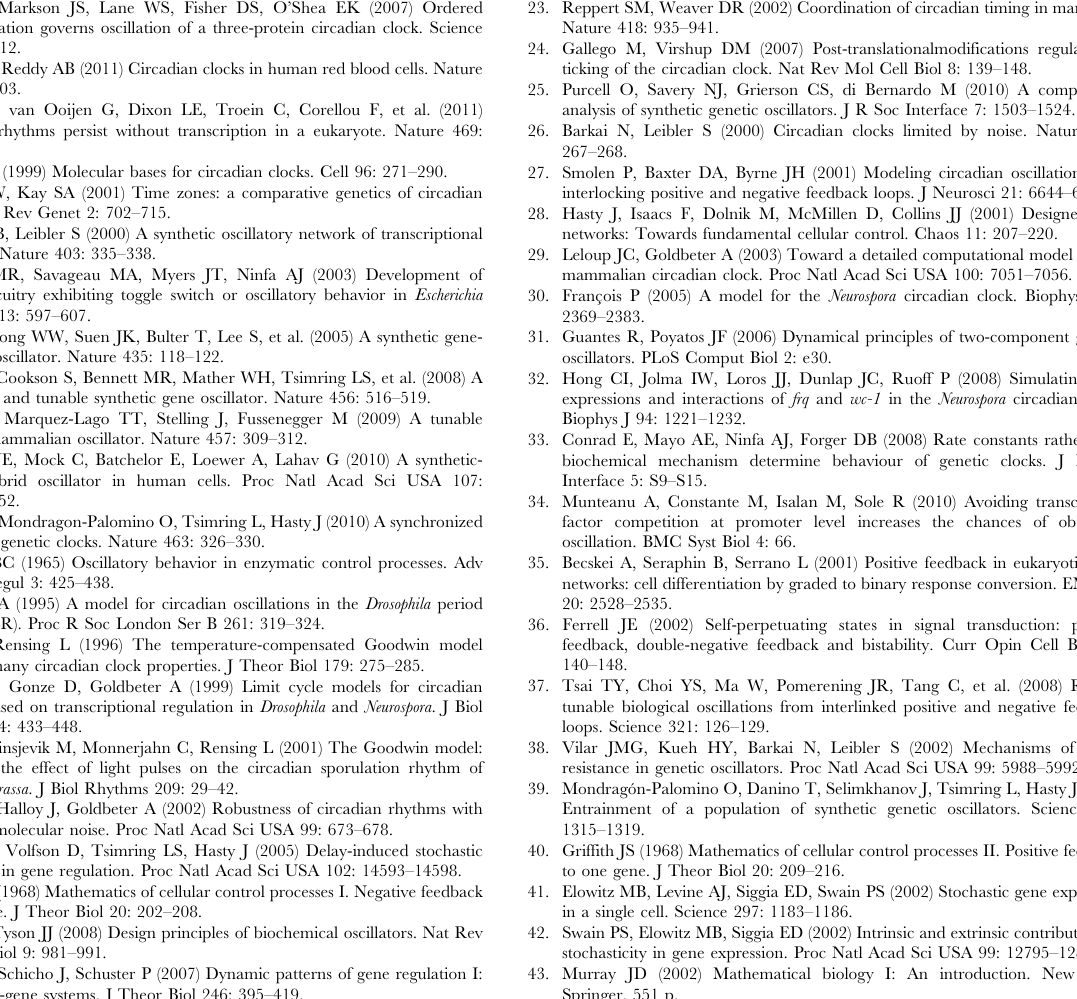
File S1 Complete deterministic model (XPPAUT soft- ware). (ODE)